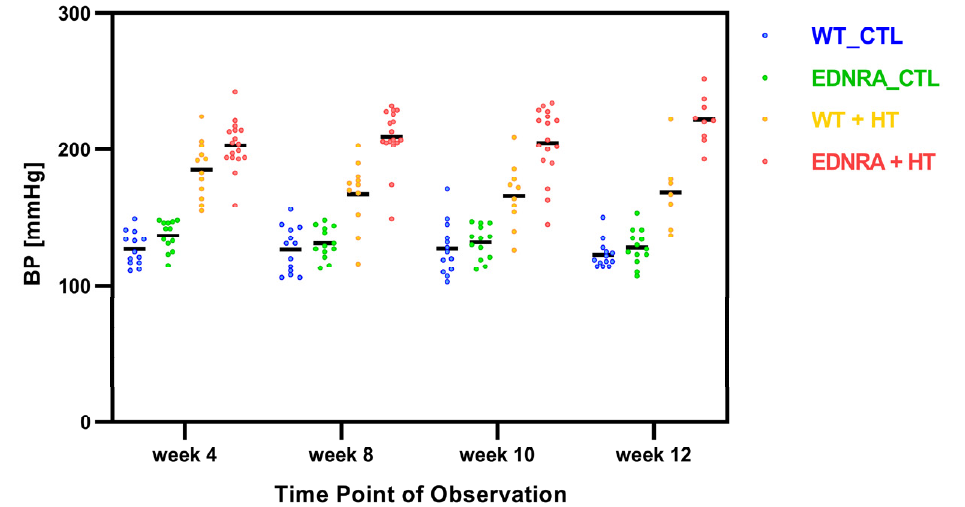
Figure 2. Comparison of individual data points and mean BP values (black bars) in mmHg of four groups at different time points of observation (see text and supplementary materials for detailed data).